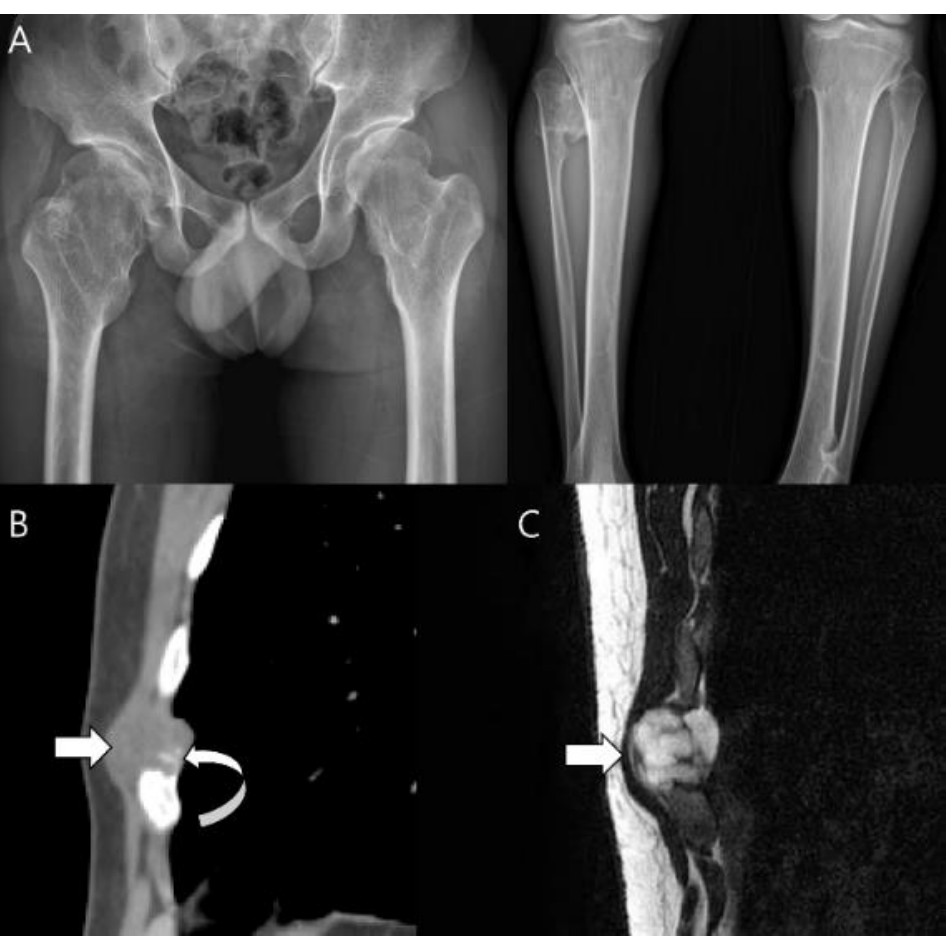
Figure 8. Secondary peripheral chondrosarcoma of the rib in a 34-year-old man. ( A ) Hip and tibial plain radiographs reveal underlying multiple exostoses. ( B ) Sagittal CT scan shows a lobulated mass with soft-tissue density (arrow) arising from the rib containing matrix mineralization (curved arrow), suggestive of a cartilage cap of sessile osteochondroma. ( C ) Sagittal T2-weighted image shows a mass of 2.3 cm in thickness with high signal intensity (arrow).